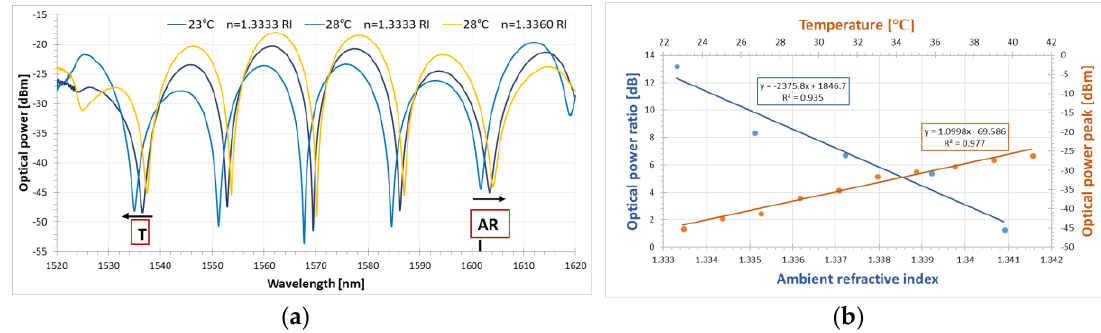
Figure 6. ( a ) Transmission spectra of FLM-DRLPG structure for ambient RI and temperature changes and ( b ) dual-parameter sensor response with linear fitting, where blue line stands for ambient RI response and orange line stands for ambient temperature response.